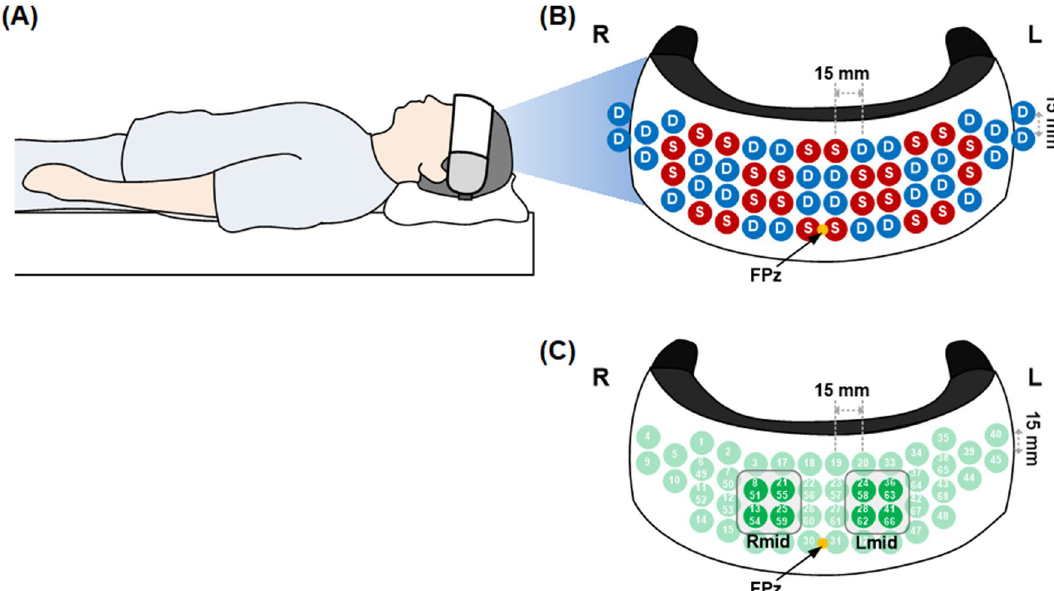
Figure 1. Data acquisition setup using continuous-wave near-infrared spectroscopy and analyzed channels for waveform analysis of oxyhemoglobin. ( A ) Data acquisition setup: The fNIRS signals from the prefrontal lobes were measured for at least 5 min in the supine position. ( B ) Arrangement of sources (red dots) and detectors (blue dots): The center of the lower optical probes is the site of a prefrontal midline electrode (FPz) in the 10–20 EEG system. The optical probes were located at an interval of 1.5 cm. ( C ) Selected channels for analysis: Among total channels, 16 channels were selected from the middle part of the left and right regions in the forehead that mostly had robust signals from the detectors considering the variations in the size and shape of the forehead. R, right hemisphere; L, left hemisphere; R mid, right middle; and L mid, left middle.